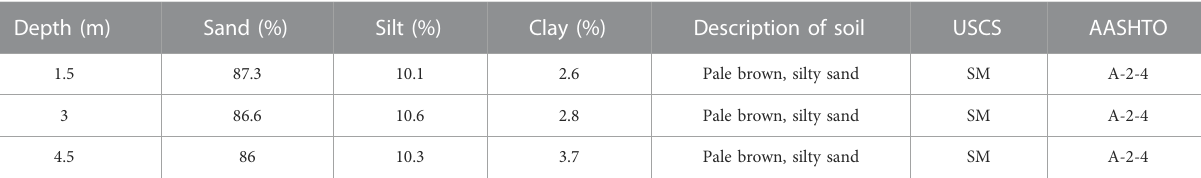
TABLE 1 Mechanical analysis of Najran soils.